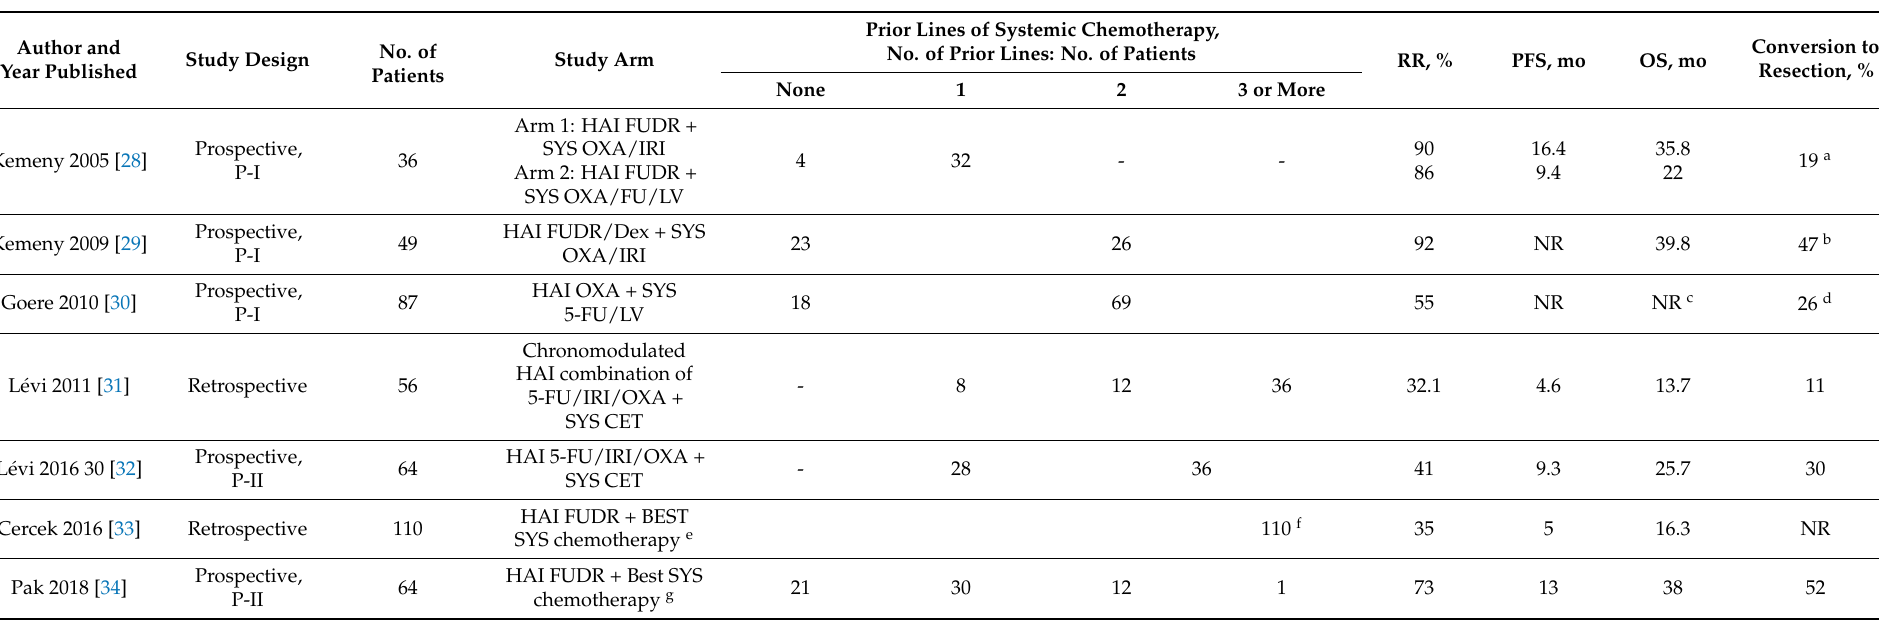
Table 1. Selected prospective trials and retrospective studies for Hepatic Arterial Infusion Chemotherapy (HAIC) with systemic